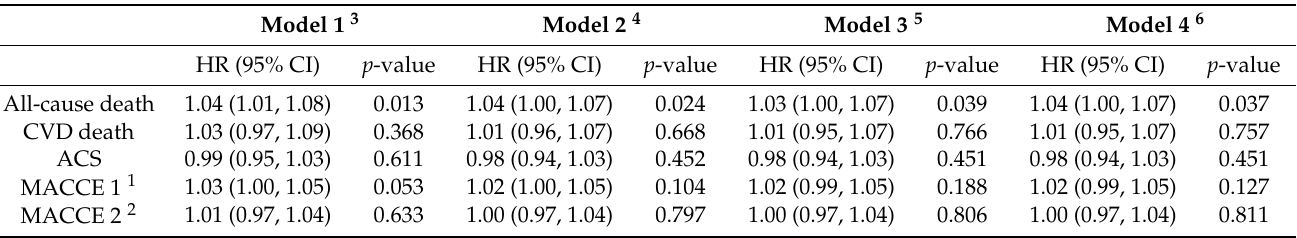
Table 2. Hazard ratios (95% confidence intervals) for baseline HCMV antibody levels (log- transformed) for outcomes of all-cause death, CVD death, ACS, and MACCE at the 20-year